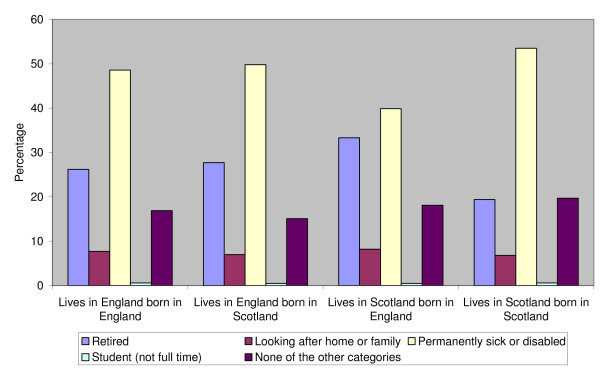
Classification of economically inactive men.